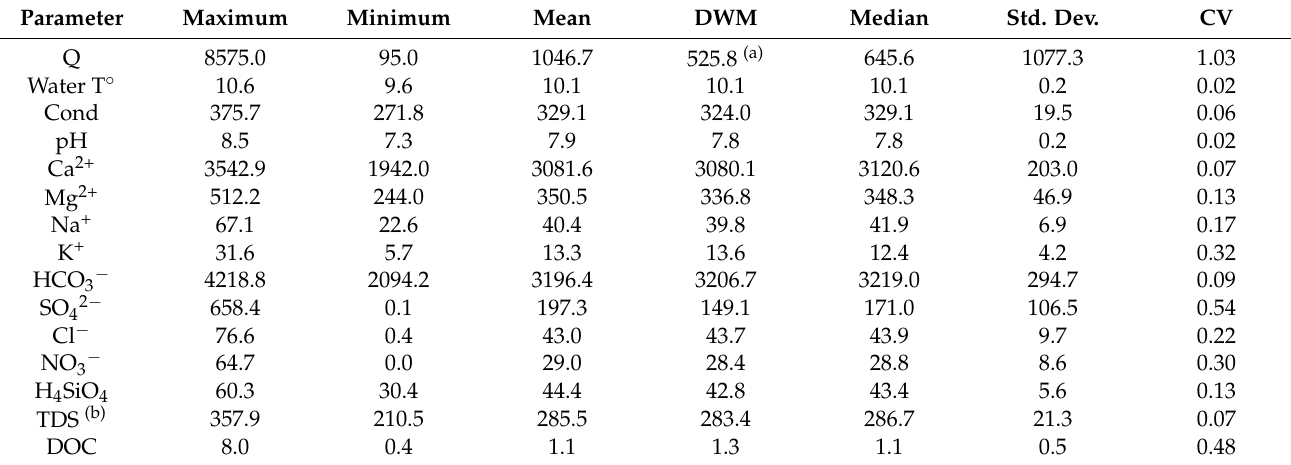
Table 1. Statistics data of the streamwater hydrochemical and physicochemical parameters during the period January 2019–December 2020 (number of samples = 297). The units are L · s − 1 (Q, discharge), ◦ C (Water T ◦ , water temperature), µ S · cm − 1 (Cond, conductivity), µ eq · L − 1 (major cations and anions: Ca 2+ to NO total dissolved solids), and mg · L − 1 (DOC, dissolved organic carbon). Coefficient of variation (CV) is the ratio between the standard deviation (Std. dev.) and the mean for each parameter. The discharge-weighted mean (DWM) was calculated according to Equation